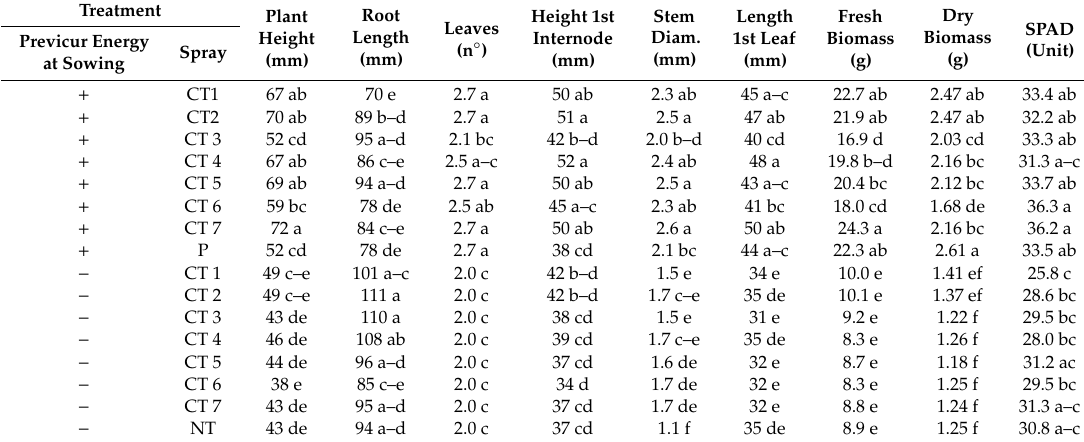
Table 4. Biometric assessments and SPAD values of tomato plants under CTs (CT1–7) produced on-farm from composts listed in Table 1, spray, with or without Previcur Energy application at sowing compared with the control Previcur Energy (P) alone and no treatment (NT). Di ff erent letters indicate significant di ff erences among means according Tukey’s HSD test at p ≤ 0.05.